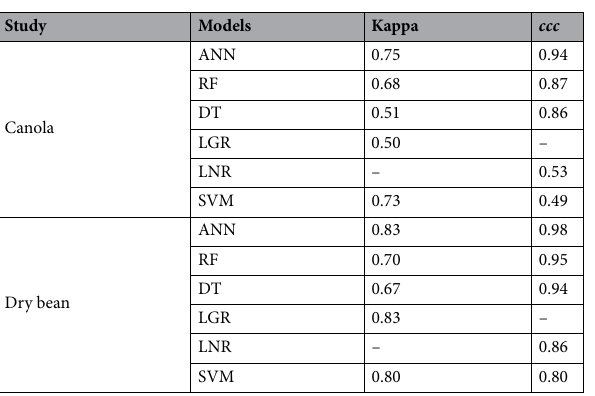
Table 5. Concordance coefficients for classification (Kappa) and regression (Lin’s ccc ) models for correspondence between observed and predicted outcomes of artificial neural networks (ANN), support- vector machine (SVM), random forest (RF), decision trees (DT), logistic regression (LGR), and linear regression (LNR) machine-learning models used to characterize the effect of leaf wetness and incubation temperature on incidence of Sclerotinia stem rot of canola and dry